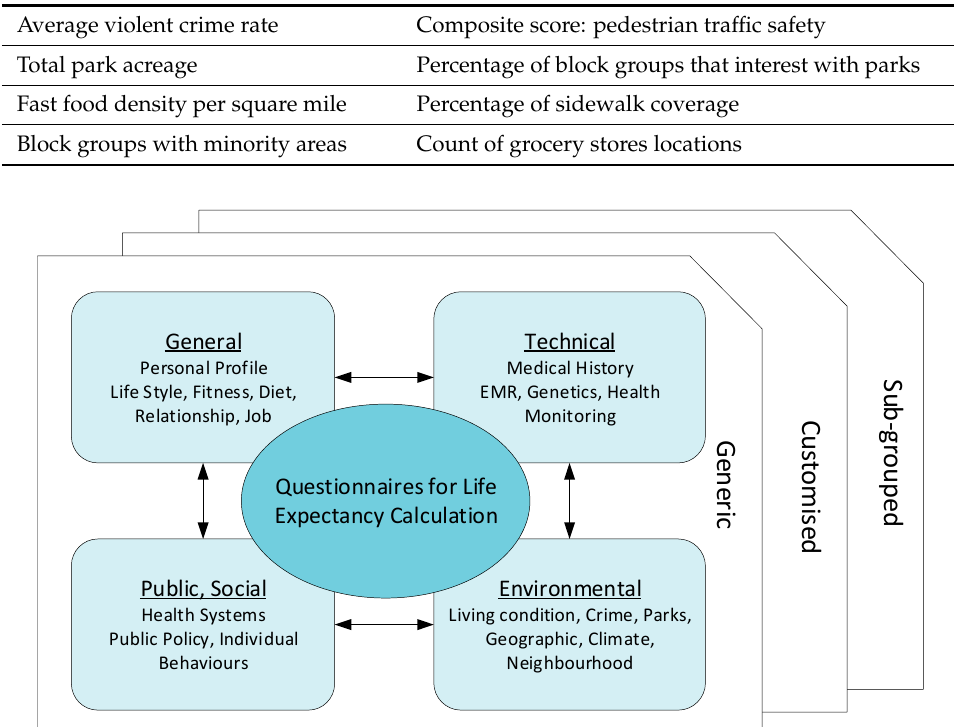
Figure 5. Questionnaires for Life Expectancy calculation. Questions are customized and further developed for specific groups and individuals. For example, a diabetic patient may have detailed questions relating to their diabetic history, types, and dietary intakes.